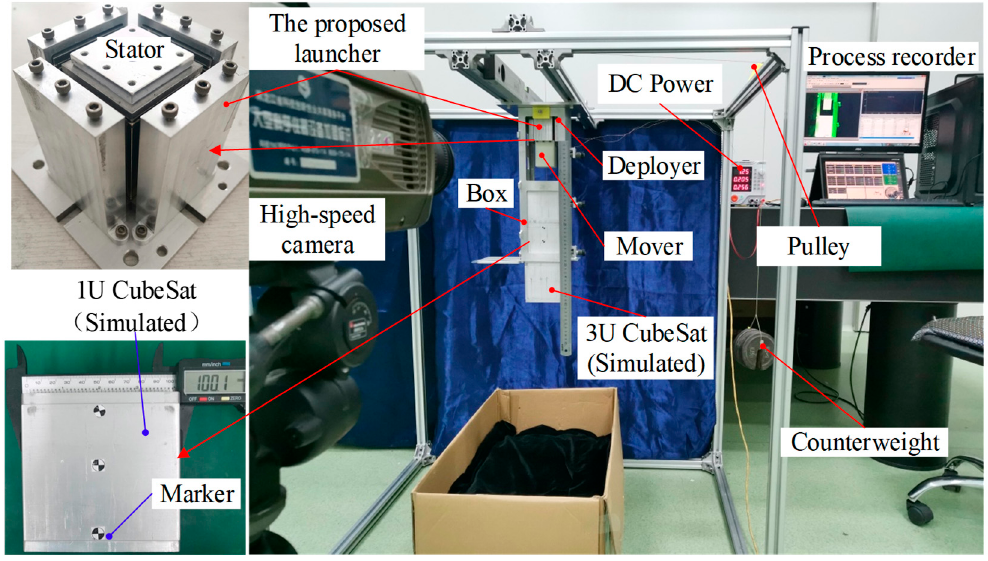
Figure 26. Ejection test of the launcher.